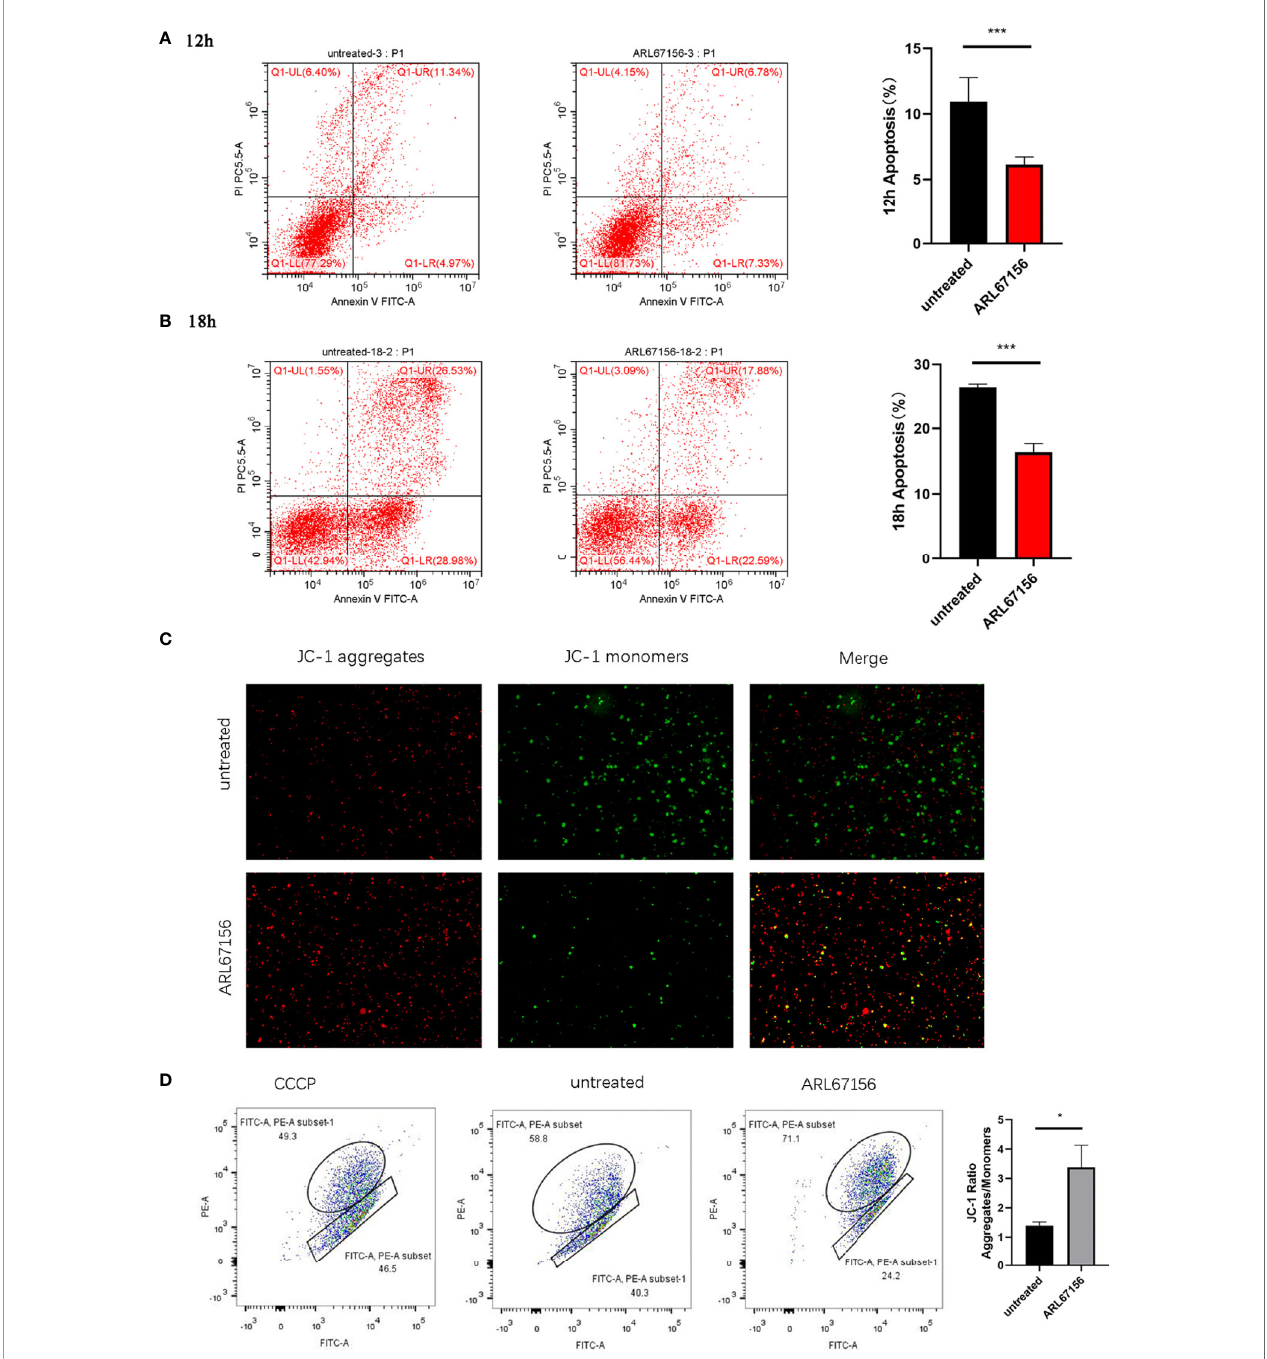
FIGURE 3 | The effect of CD39/CD73 inhibiting on the apoptosis and mitochondrial membrane potential ( DY m) of dNK cells. dNK cells were isolated from healthy decidua of fi rst-trimester pregnancies (n = 3), incubated in the absence or presence of the CD39 inhibitor ARL67156 for 12 hours (A) or 18 hours (B) , and then double stained with Annexin V and DAPI (mean ± SEM, ***P < 0.001, two-tailed t tests). (C) Microscope images taken from the JC-1 monomer fl uorescence channel (green) and aggregate fl uorescence channel (red) of dNK cells (n=5) with and without incubation with ARL67156 for 12 h. The monomeric JC-1 form was excited using a 525 nm laser, observed at an emission wavelengths of 514~529 nm, and is shown in green. The aggregate form was excited using a 566 nm laser, observed at 585~590 nm, and is shown in red. (D) Flow cytometry-based JC-1 assay as a measure of changes in mitochondrial membrane potential in dNK cells (n=5) induced by the CD39 inhibitor. The upper left quadrant indicates the cells with more JC-1 as aggregates with red fl uorescence (i.e., normal DY m), the lower right quadrant indicates the cells with more JC-1 as monomers with green fl uorescence (i.e. low DY m). (mean ± SEM, *P < 0.05 compared with the untreated